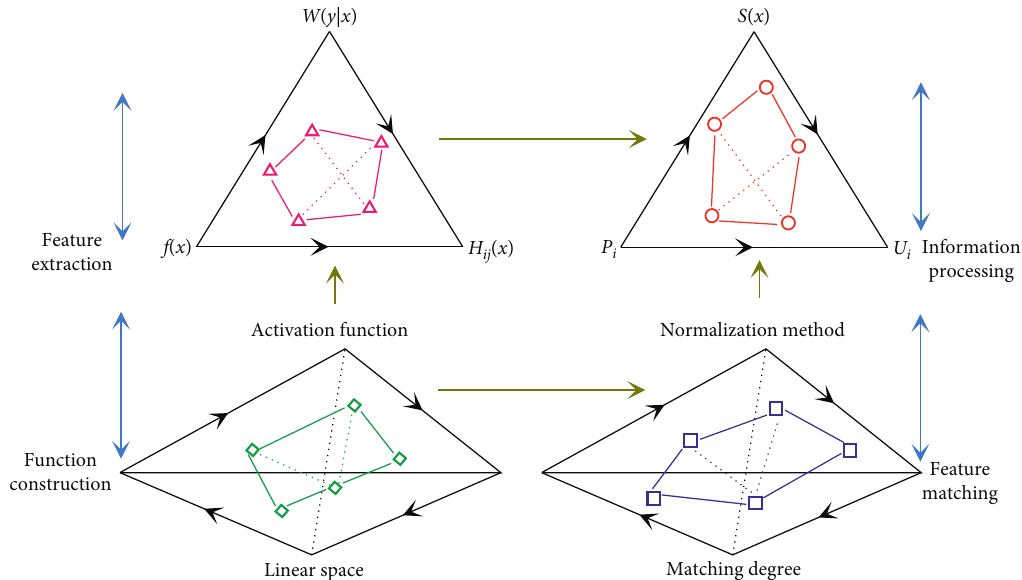
Figure 4: Scene matching flowchart for children’s psychological distress based on deep learning